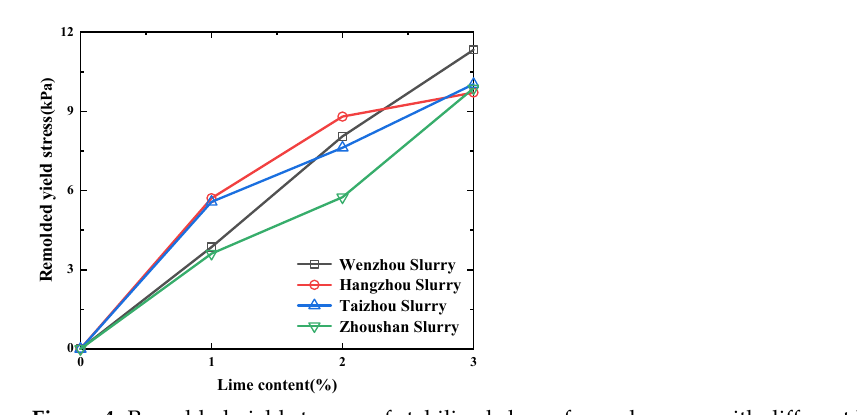
Figure 3. Compression indices of lime-stabilized slurry for each group with different lime dosages.